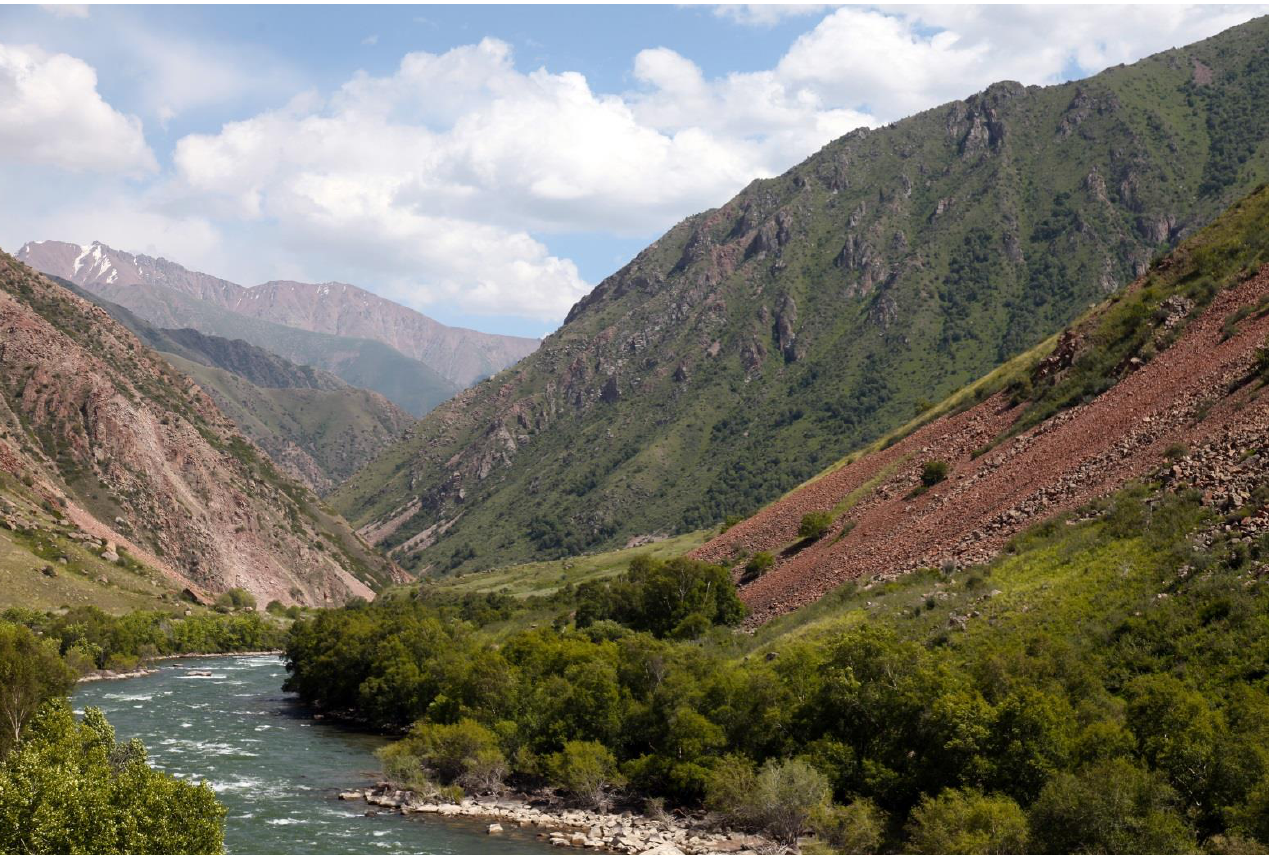
Fig. 3. Kekemeren river 3 km N of Sary-Oi, left side – Dzhumgaltoo Mts., right side – Suusamyr-Too Mts.